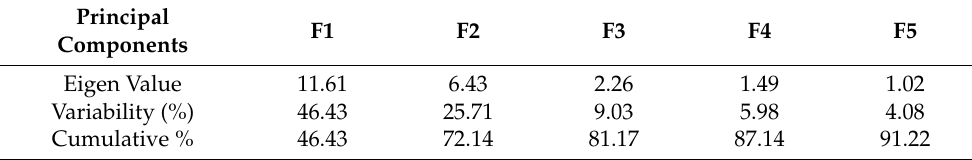
Table 3. Eigen value, factor scores, and contribution of the first five principal component axes to variation in pak choi grown under the different ratios of red and white light.